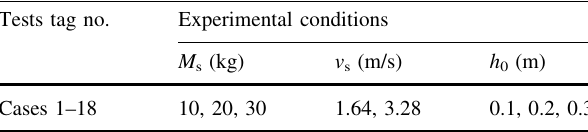
Table 3 Parameters of rock avalanche–debris flow